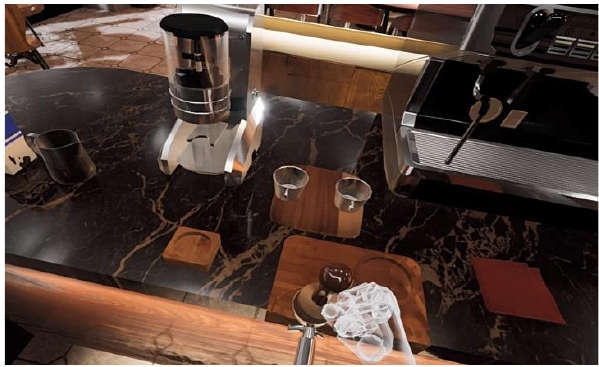
Figure 16. A screenshot of the moment when the subject focused on the tamper shown in Figure 15.